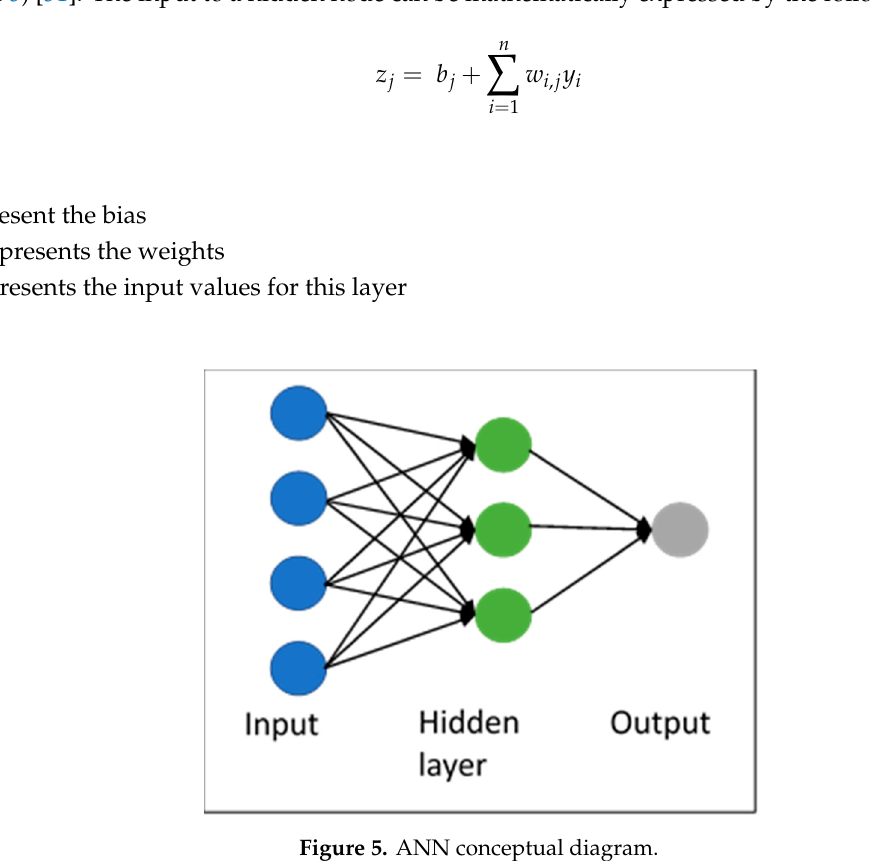
Figure 5. ANN conceptual diagram.